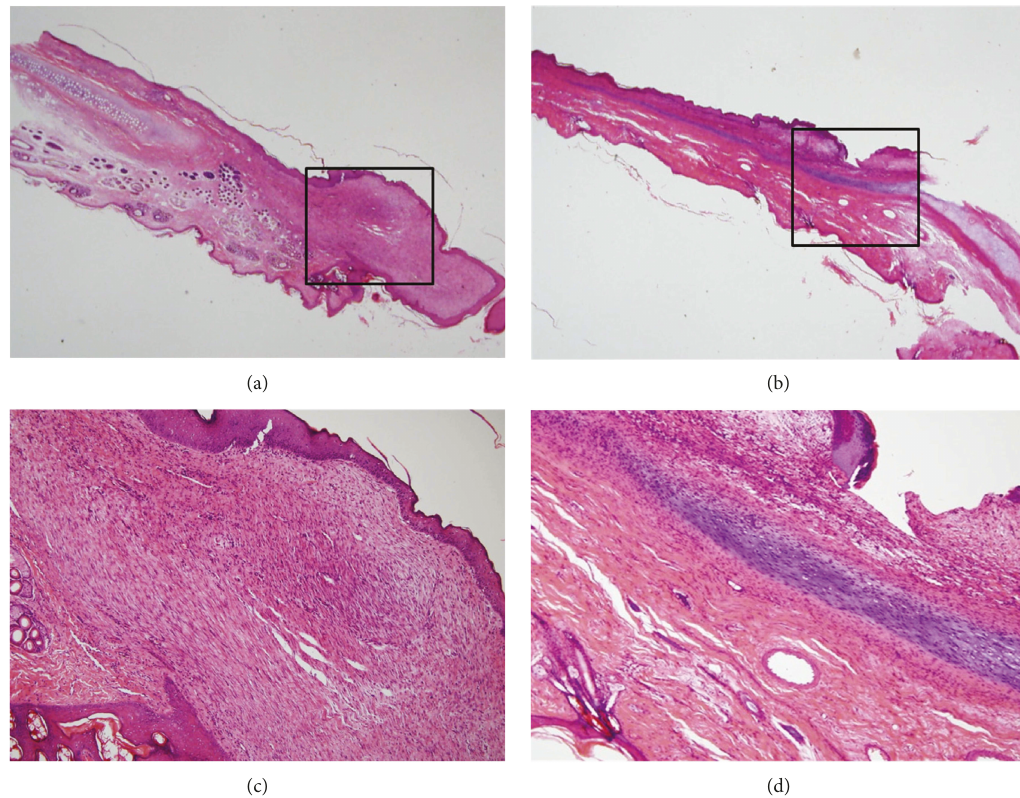
Figure 4: Histology of auricular cartilage defect. (a) Normal cartilaginous tissue was not visible in black square box in the control group. (b) New cartilage tissue was shown in black square box in the experimental group. (c) Fibrous tissue formation was observed instead of chondrocyte and extracellular matrix (ECM). (d) Typical cartilaginous features with chondrocytes, chondroblasts, and cartilage-speci fi c ECM deposition were shown. Sections were stained with hematoxylin and eosin (magni fi cation, a, b: 10x, c, d: